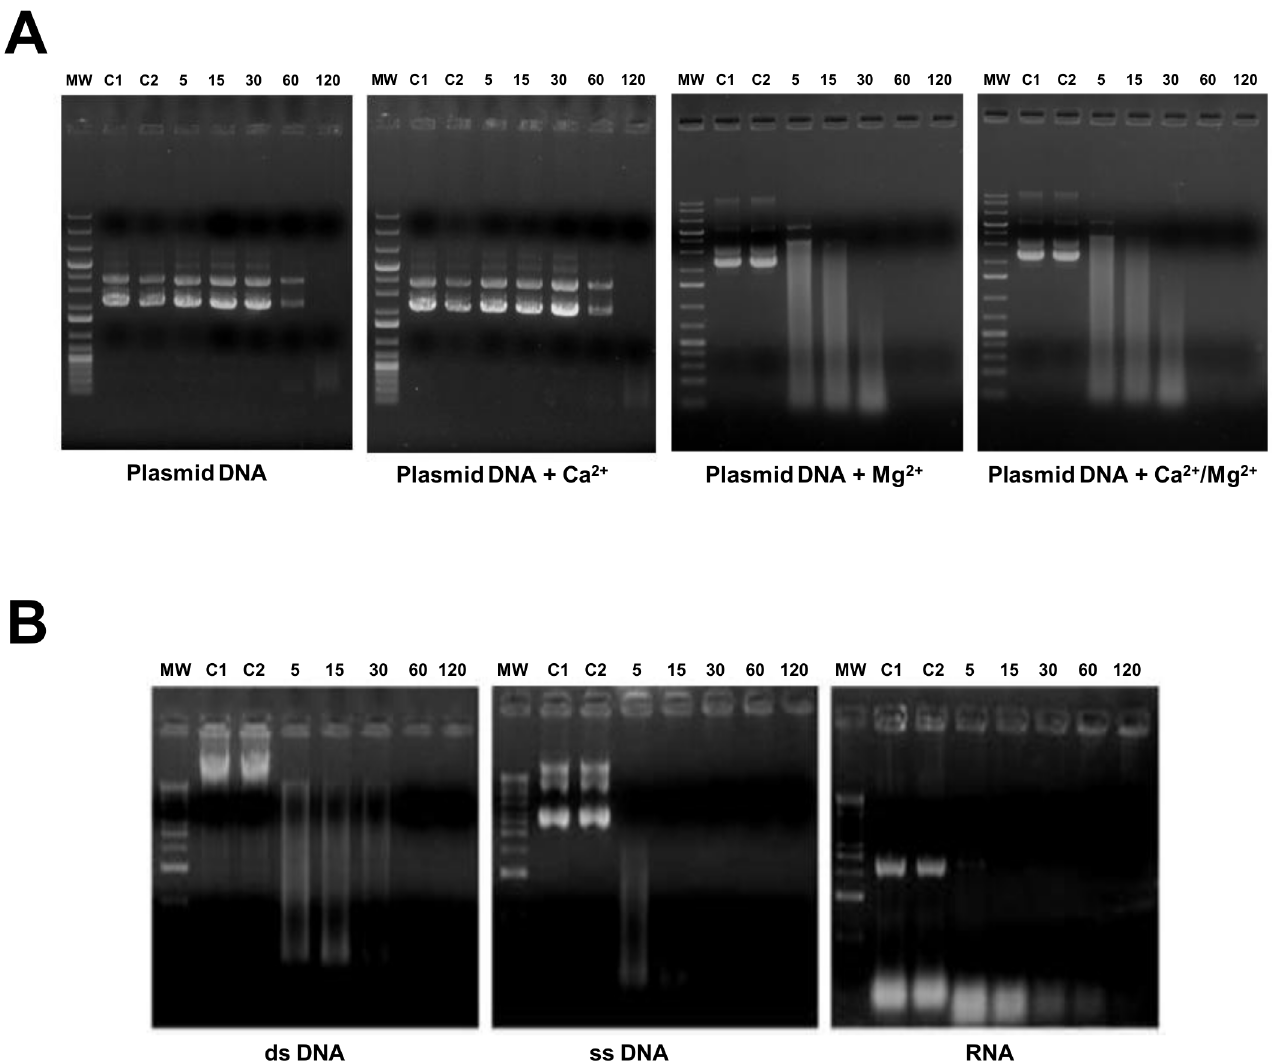
Fig 3. Nuclease activity of GST-Mm19 fusion protein. (A) Effect of divalent cations on nuclease activity of purified GST-Mm19 against pasmid pCR2.1 DNA. Nuclease activity was analyzed in the absence or presence of 2 mM of different divalent cations (indicated under each panel). Molecular weight markers, 1 kb DNA Plus Ladder (Thermoscientific), are shown on the left margin of each panel. Lanes C1 and C2 in each panel are plasmid DNA untreated or treated with GST protein, respectively. Purified GST-Mm19 fusion protein was incubated with pasmid pCR2.1 DNA. Incubation times in minutes are indicated above each lane. All reactions were performed at 37°C. (B) Substrate specificity of nuclease activity of purified GST-Mm19. Nuclease activity of GST-Mm19 was assessed against Vero cell double-stranded DNA (left panel), M13 phage single-stranded DNA (middle panel), and E . coli strain BL21 total RNA (right panel). The positions of 1 kb DNA ladder markers are indicated as MW on the left of each panel. Lanes C1 and C2 in each panel indicate end point reactions of the undigested nucleic acid controls after incubation in the nuclease buffer alone or supplemented with GST protein, respectively. Reactions were stopped at the times indicated above each